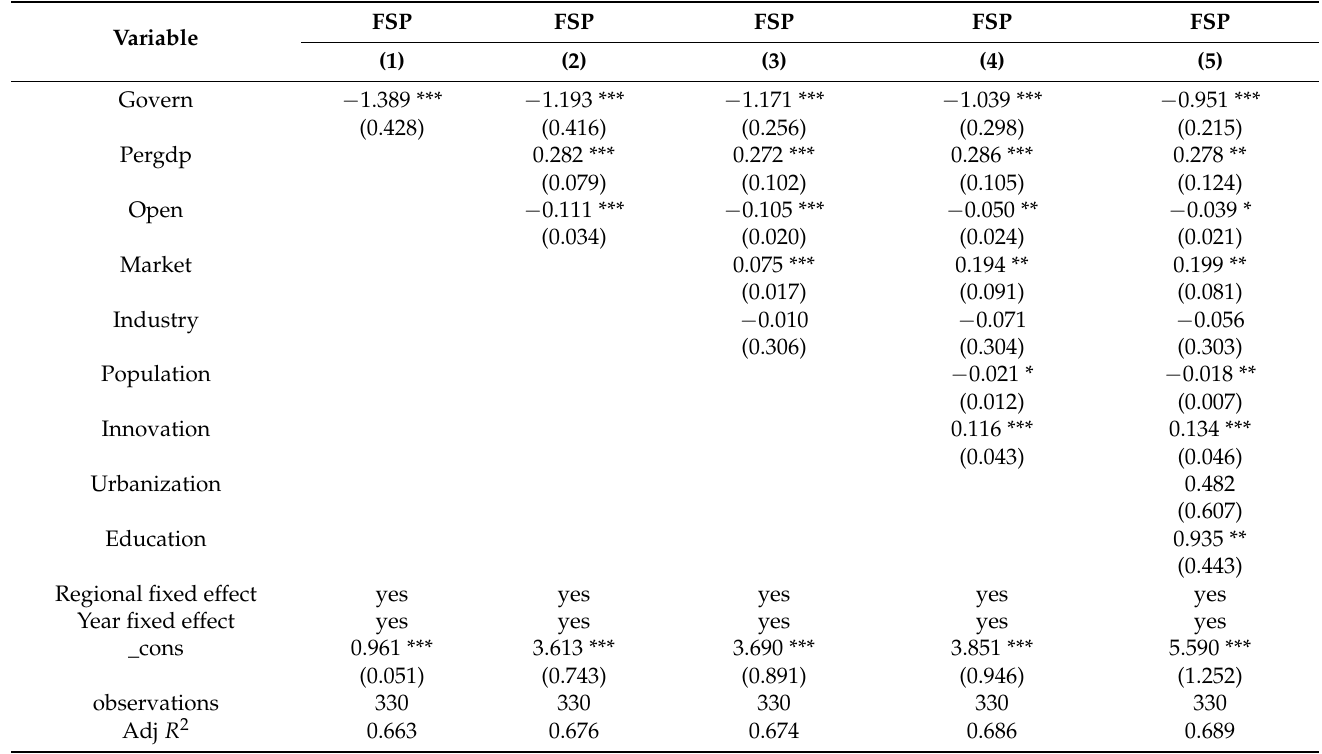
Table 4. Estimation results of OLS fixed effect